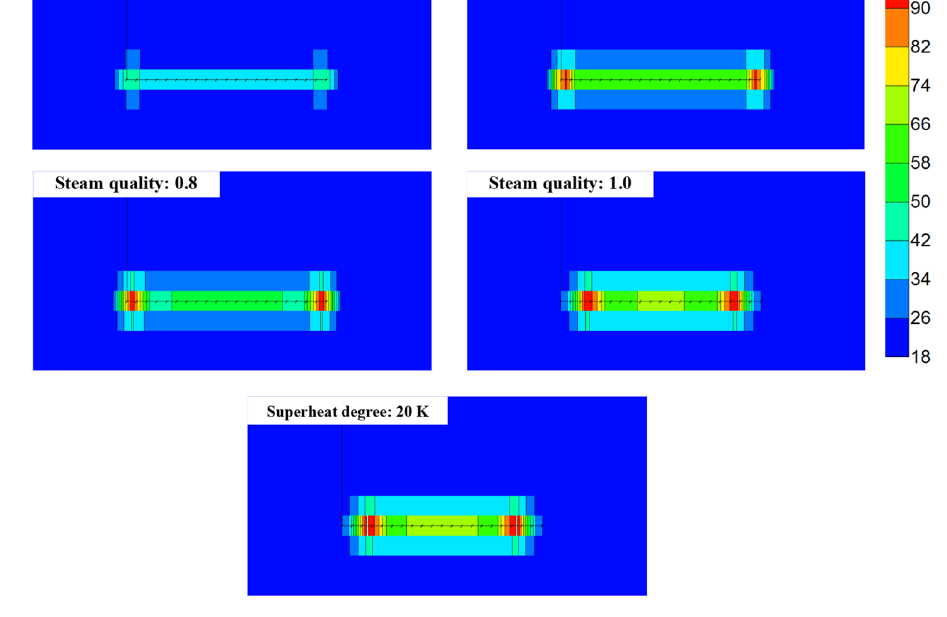
Fig. 7 Cumulative oil produc- tion under different steam state conditions